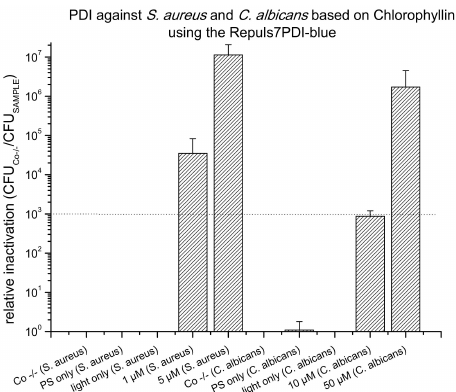
Figure 6. Photodynamic Inactivation of S. aureus and C. albicans shown as relative inactivation (CFU Co − / − / CFU sample ). ChlorophyllinwasphotoactivatedusingtheRepuls7PDI-blue(radiantexposure: 6.6 J · cm − 2 , irradiance: 9 mW · cm − 2 ). The bars represent the average of three independent biological replicates including the standard deviations as error bars. The black dashed line corresponds to a reduction of 3 log 10 (99.9% killing e ffi cacy). Three controls were included in this experiment. Co − / − : double negative control; PS only: dark control; and light only: light